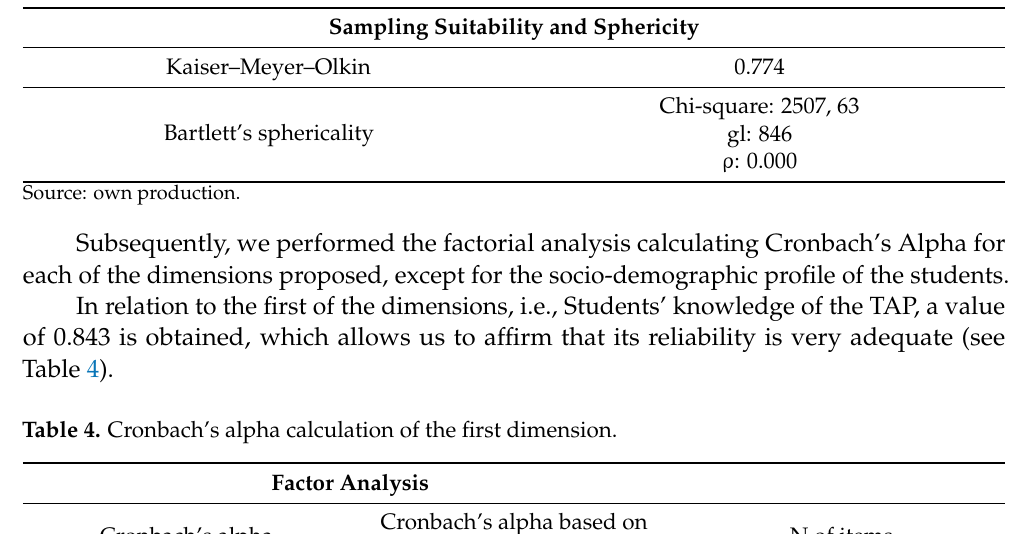
Table 3. Sampling adequacy and sphericity statistics.